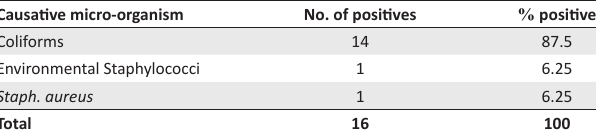
TABLE 9: Mastitis-causative organisms isolated from 16 cows with subclinical mastitis samples. Causative